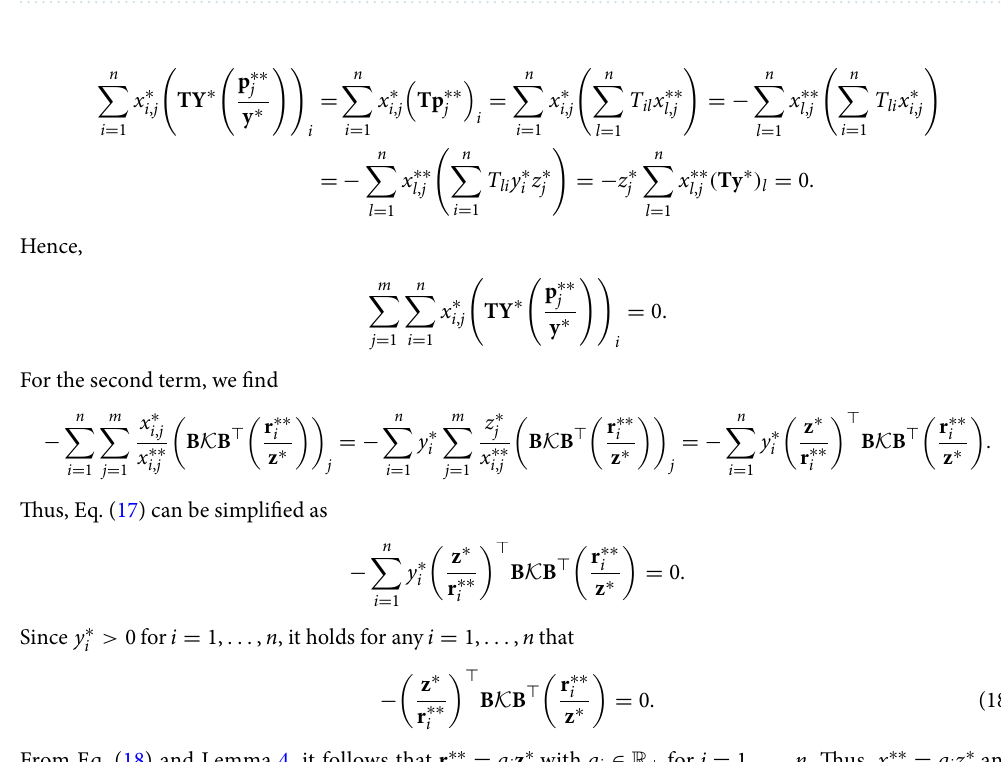
Figure 3. A metapopulation network composed of three patches. Each patch contains a local population composed of three species (1, 2 and 3), in cyclic competition, as shown by the black arrows. The red arrows denote migrations among the patches in the directions